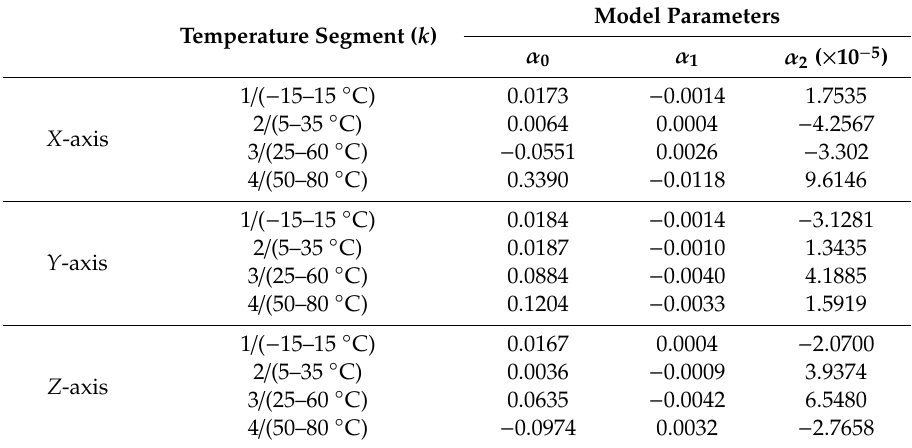
Table 2. Table of fitting coe ffi cients of static data.